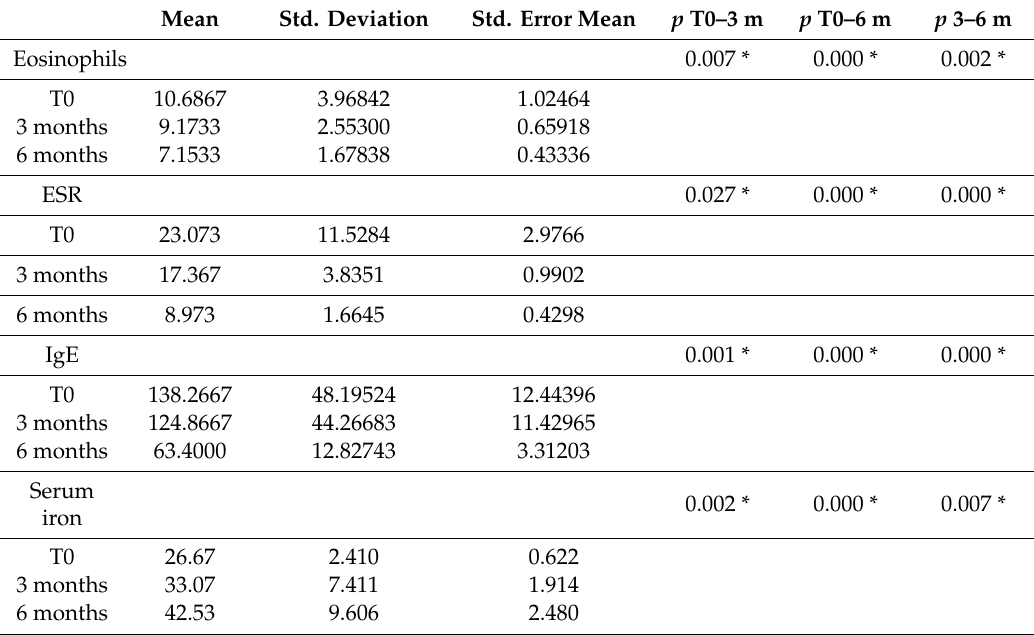
Table 6. Correlation of disease progression in the second subgroup, which received PPI